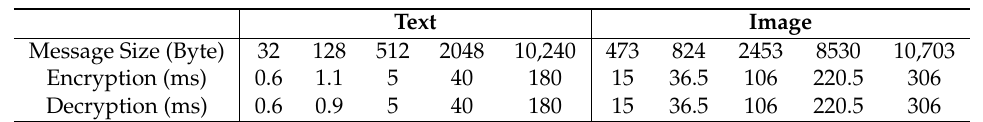
Table 2. Computation time on UAVs.